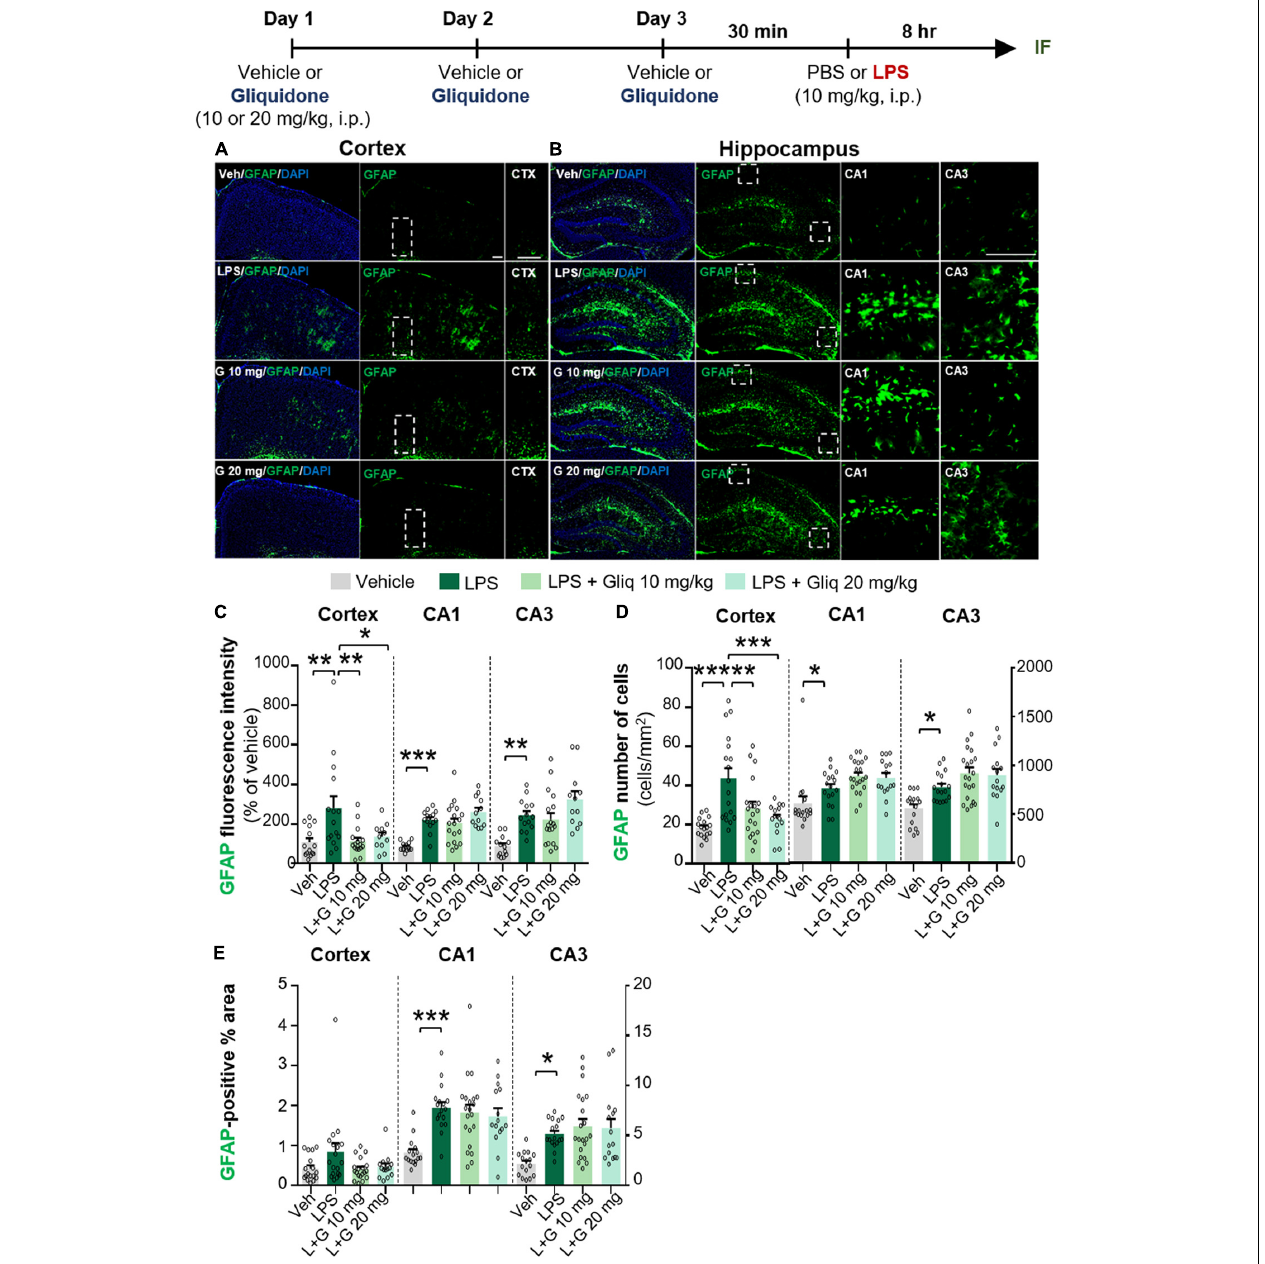
FIGURE 2 | Gliquidone decreases LPS-stimulated astrogliosis and the number of GFAP-positive cells in the cortex in C57BL6/N mice. (A,B) Immunofluorescence staining of GFAP expression in brain slices from mice treated as shown at the top of the figure. (C–E) Quantification of the results in (A,B) ( n = 12–18 brain slices from 4 mice/group). * p < 0.05, ** p < 0.01, *** p < 0.001. Scale bar = 100 µ